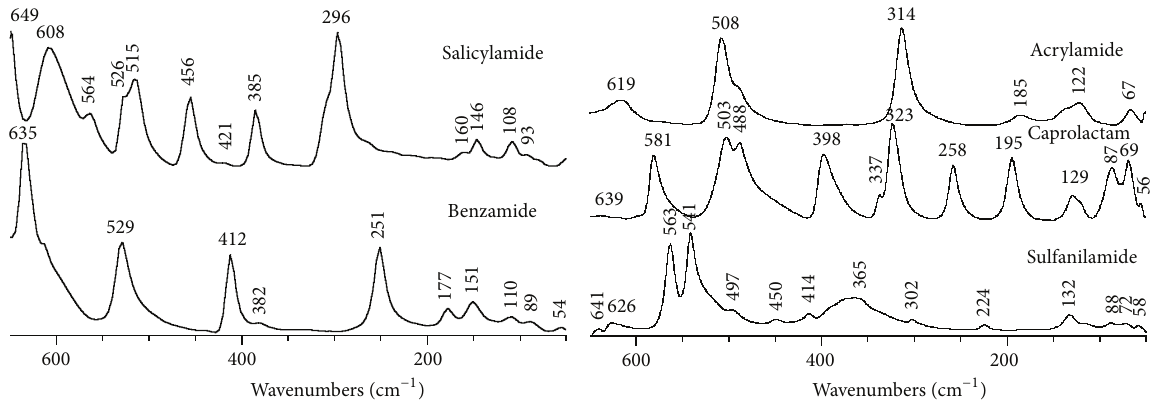
Figure 3: FIR spectra of acrylamide, benzamide, salicylamide, caprolactam, and sulfanilamide in the 650–50 cm −1 region.